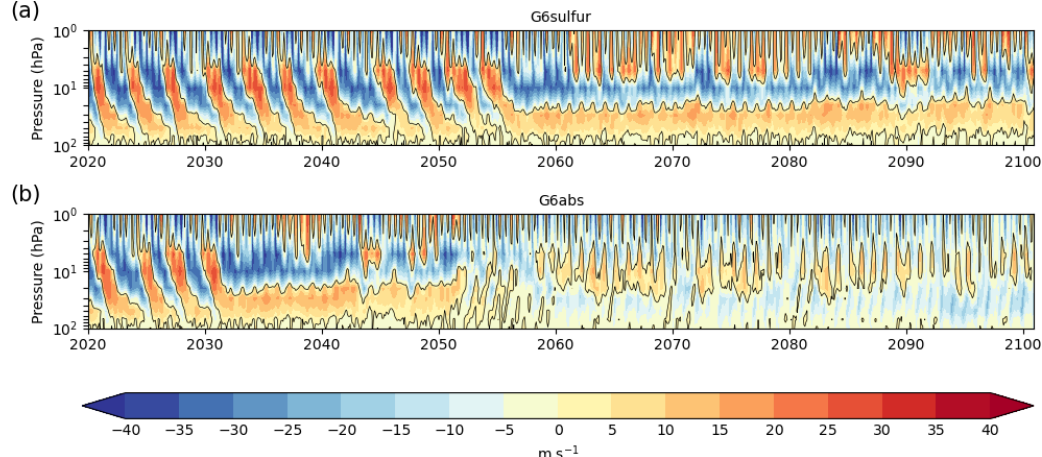
Figure 12. The QBO diagnosed from one of the three ensemble members (all ensemble members show similar behaviour) for (a) G6sulfur and (b) G6abs. Plots consist of time–pressure cross sections of 5 ◦ N–5 ◦ S mean zonal stratospheric winds (ms − 1 ) from a single ensemble member. Positive values indicate westerly winds and negative values indicate easterlies; the black contour is at 0ms − 1